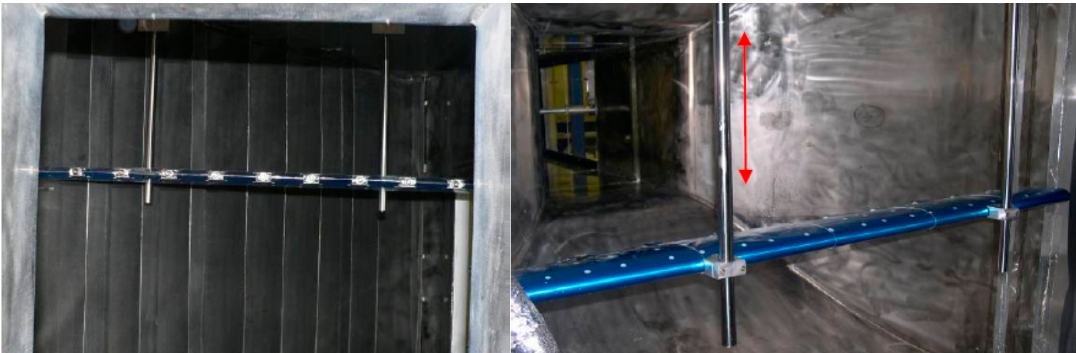
Figure 3. Sprinkler ramp.